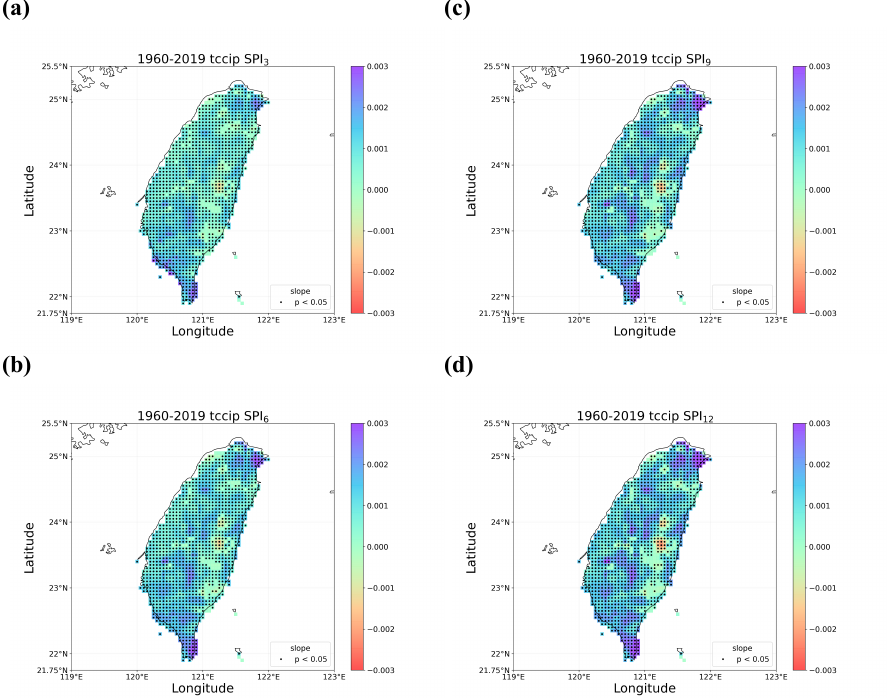
Figure 2. Spatial patterns of trends in the SPI series from 1960 to 2019 detected using linear regression;